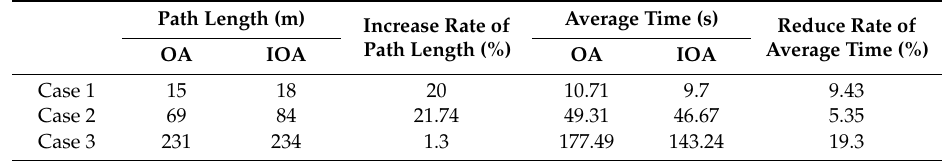
Table 2. Path length (m), increase rate of path length (%), average time (s), and reduced rate of average time